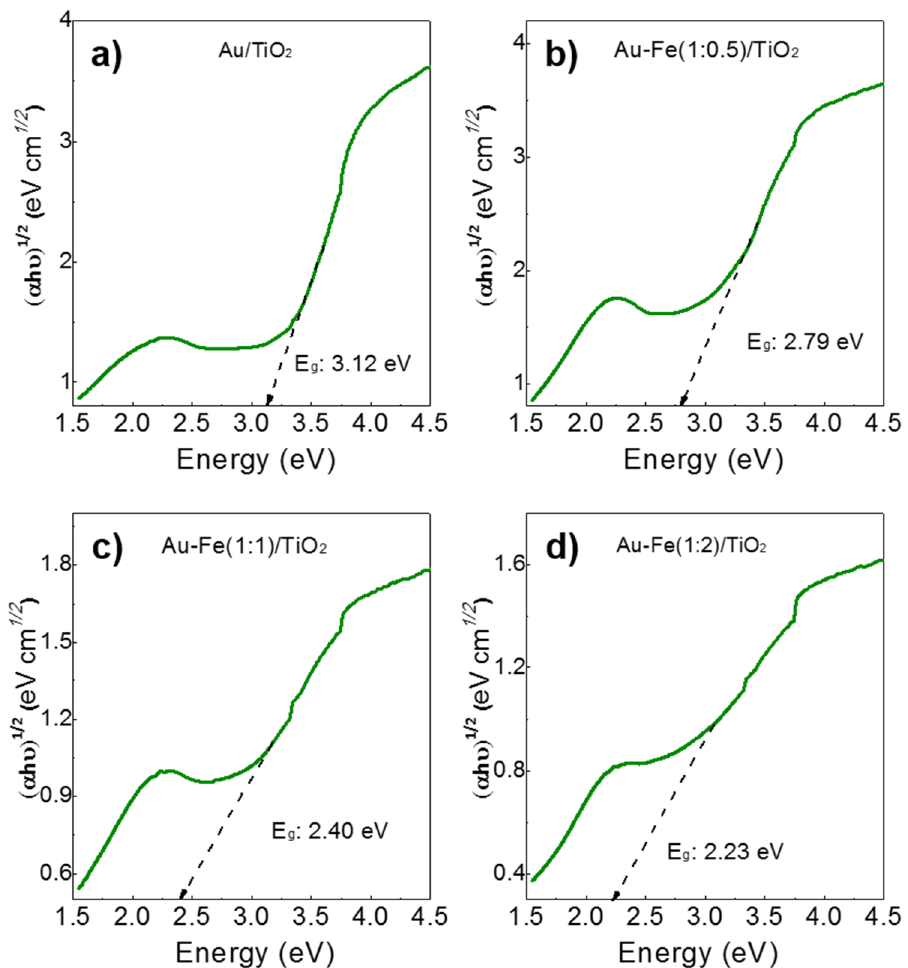
Figure 3. Absorbance spectra for the indirect electronic transition vs. E (eV) of ( a ) Au / TiO 2 , ( b ) Au-Fe(1:0.5) / TiO 2 , ( c ) Au-Fe(1:1) / TiO 2 and ( d ) Au-Fe(1:2) / TiO 2 .